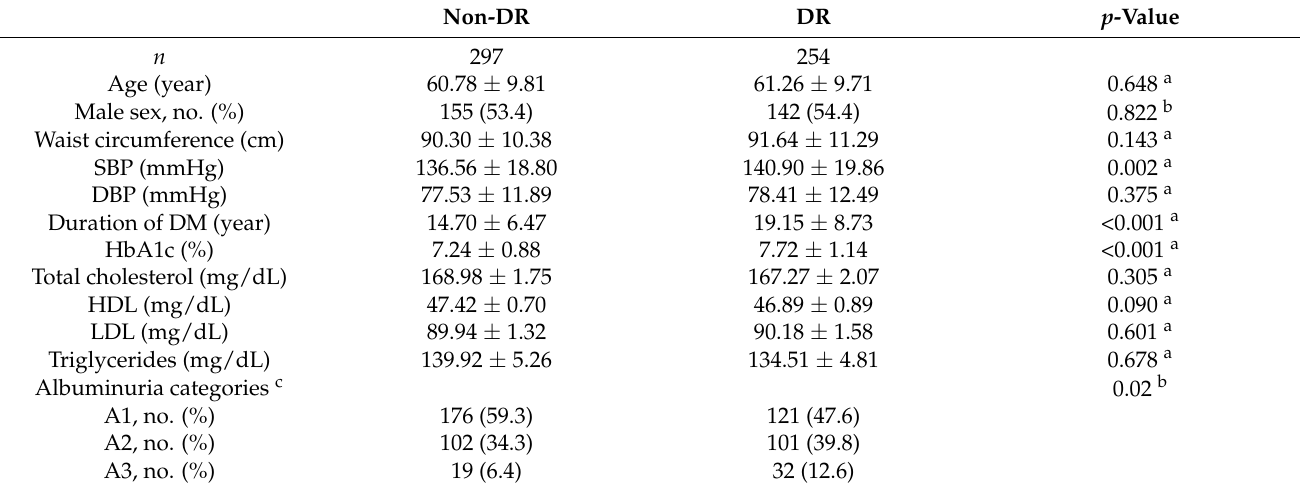
Table 1. Baseline characteristics of